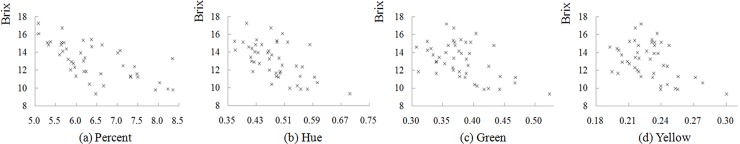
The scatter of the sugar content against with different image parameters.